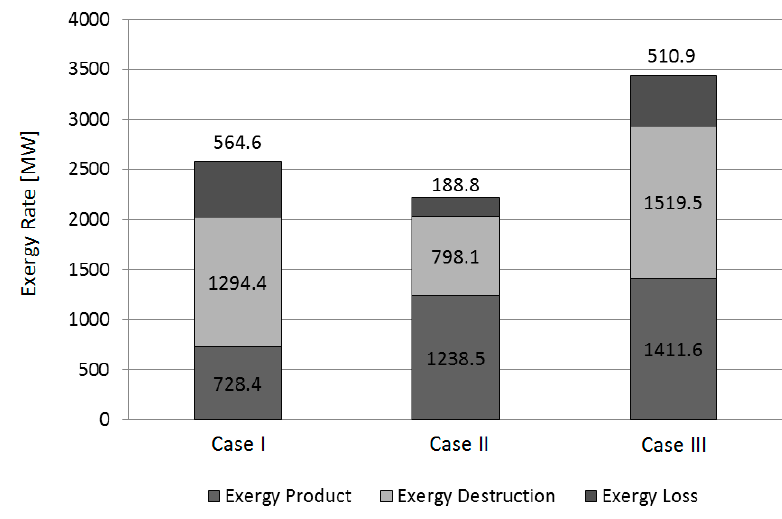
Figure 6. Comparison of the cases using results from the exergy analyses.